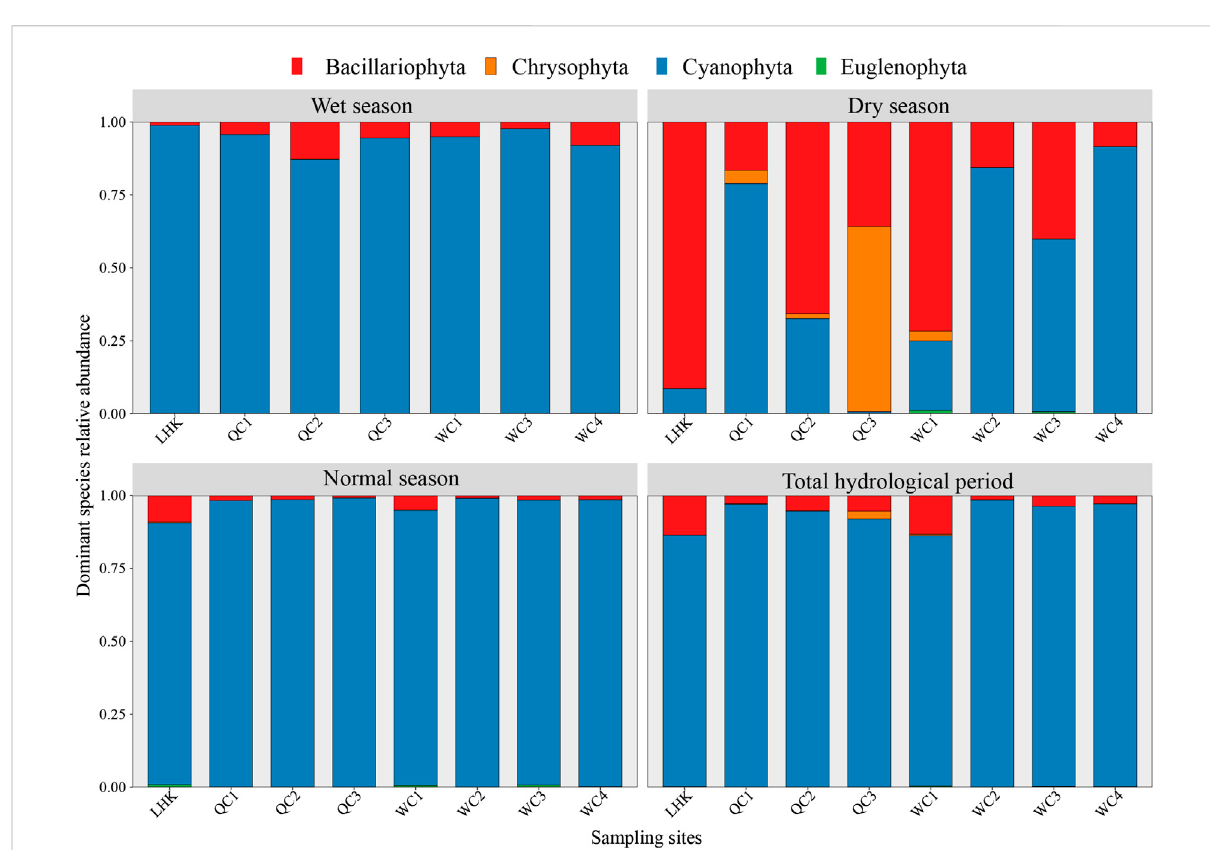
FIGURE 2 Spatial-temporal variation in the relative abundance of the dominant phytoplankton species in different hydrological